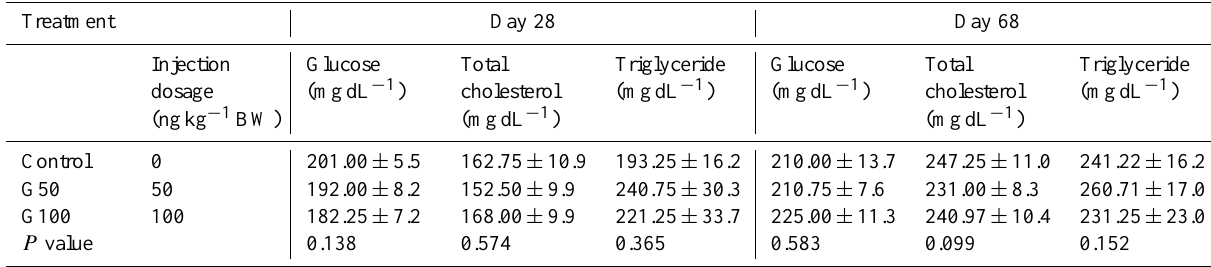
Table 4. Serum biochemical characterizes in geese subjected to IP injection of ghrelin.